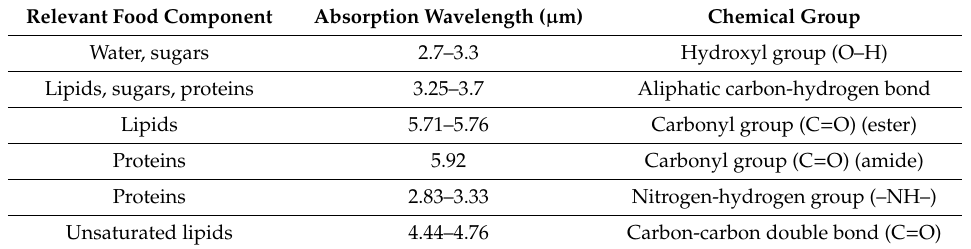
Table 1. The infrared absorption bands characteristic of chemical groups relevant to the heating of food